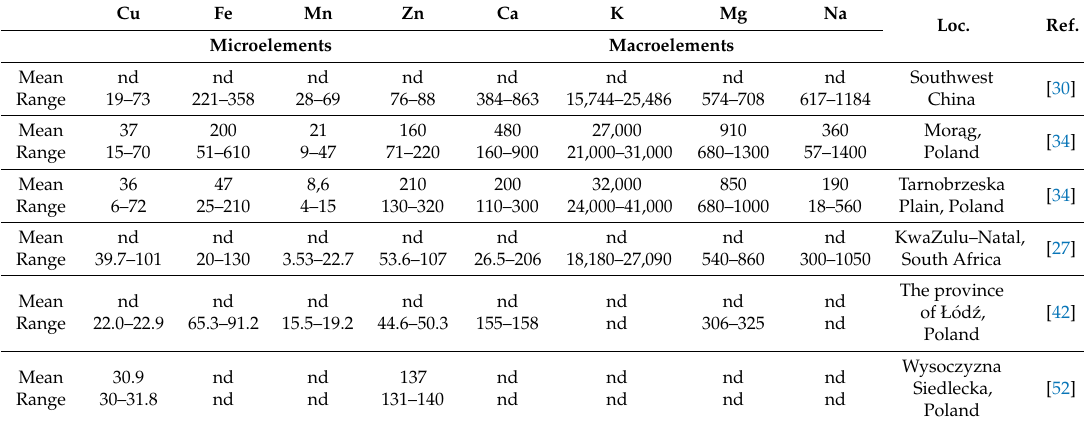
Table 3. Minerals in Boletus edulis (adapted) [mg / kg d.w.].